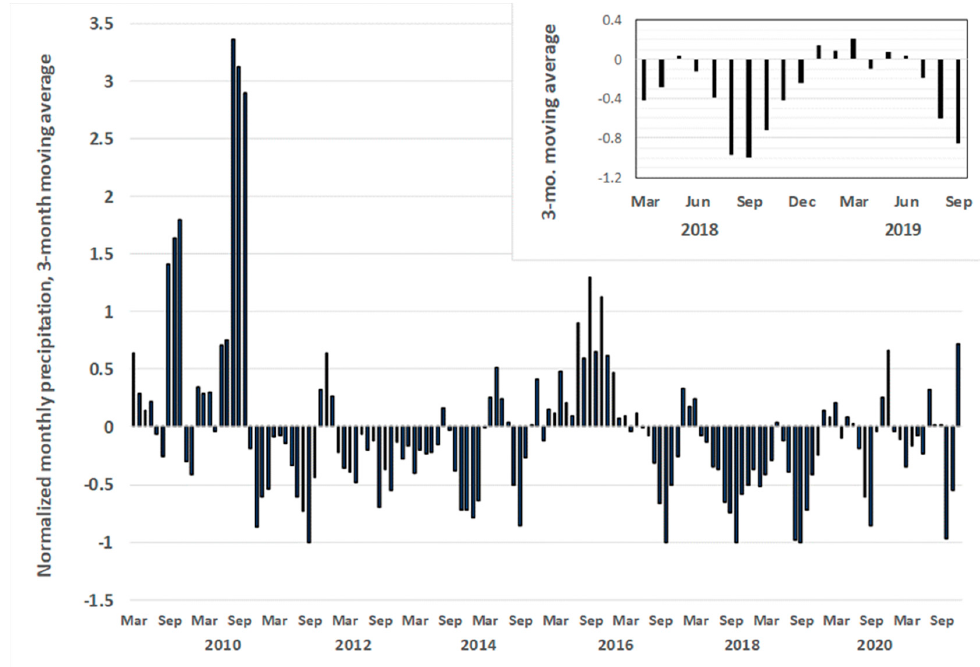
Figure 9. Normalized monthly precipitation calculated as a 3-month moving average from 2009 to 2020. Zero horizontal line represents the average monthly precipitation; deviations above and below this show months of higher precipitation and drought, respectively.